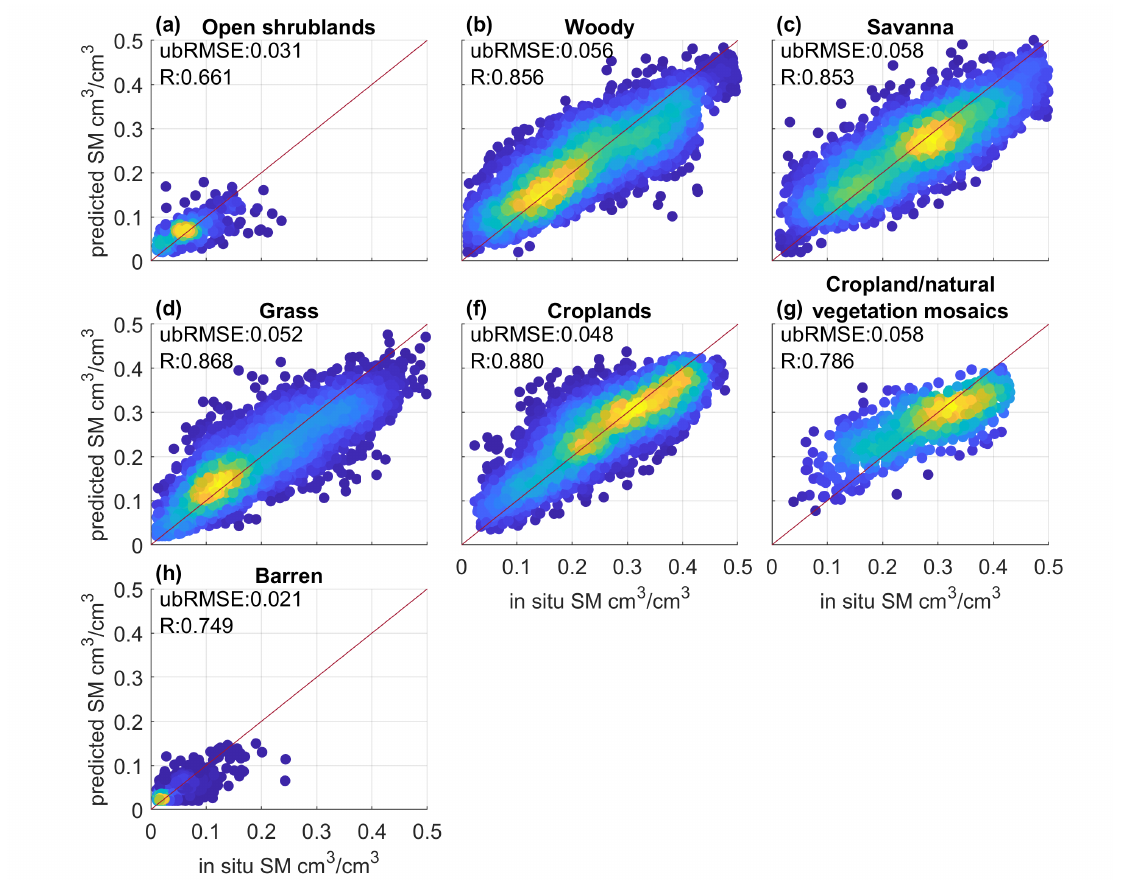
Figure 9. Scatter plots of SM retrievals for different types of vegetation land